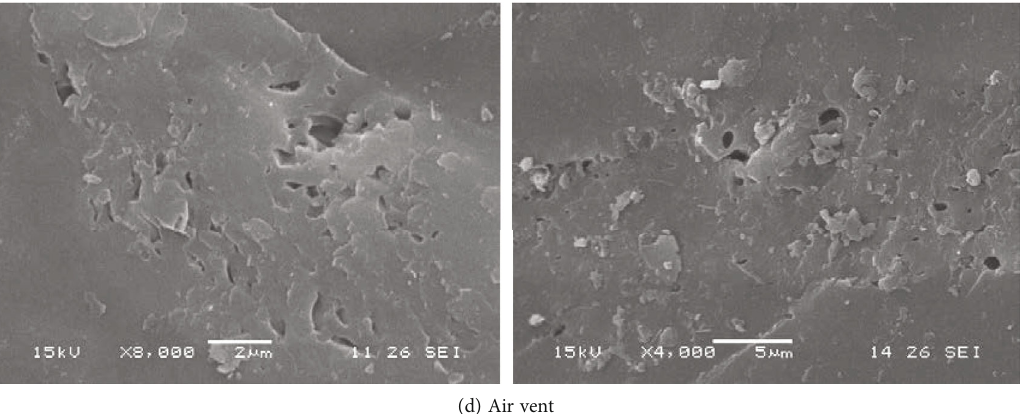
Figure 3: Pore characteristics under a scanning electron microscope.